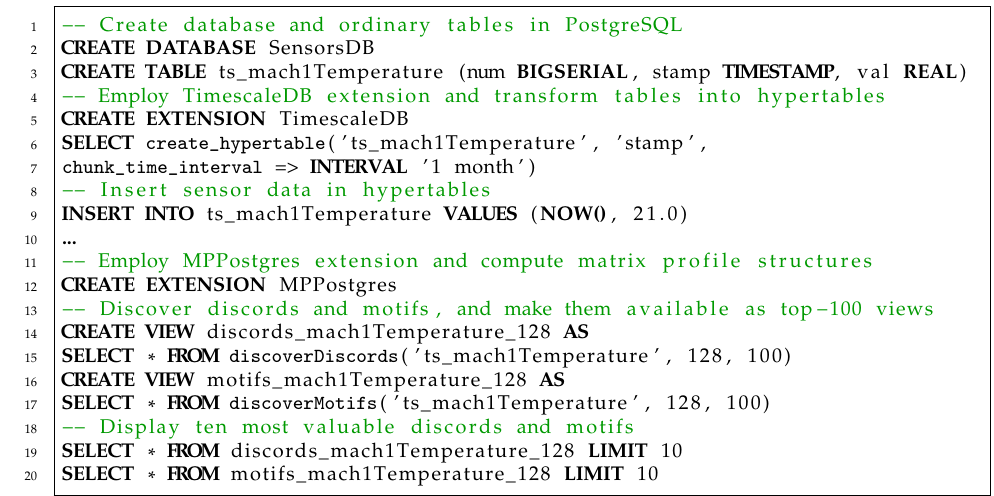
Figure 14. Create and use a sensor database with TimescaleDB and MPPostgres in